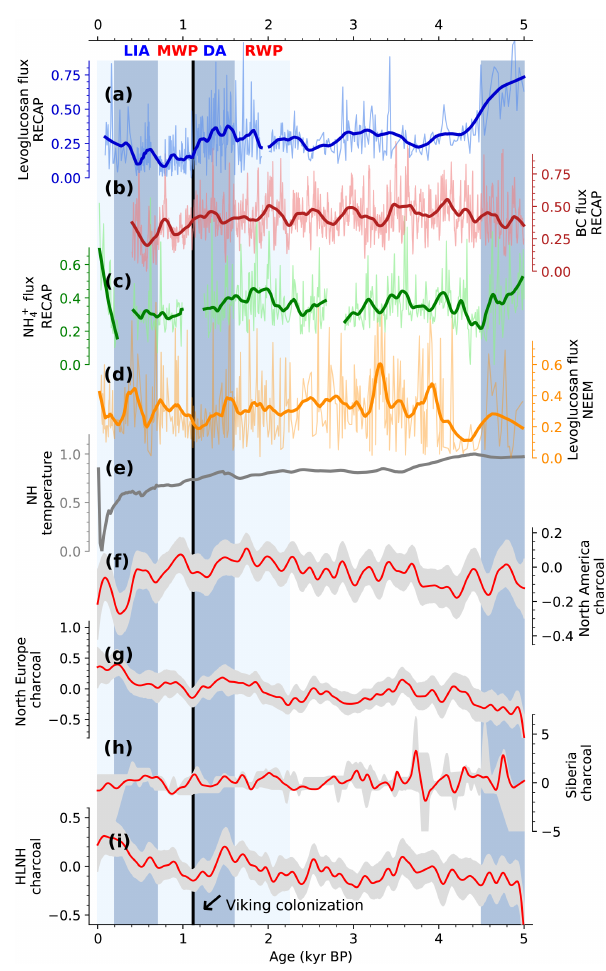
Figure 3. Normalized 5kyr time series of (a) RECAP levoglu- flux; (d) NEEM cosan flux; (b) RECAP BC flux; (c) RECAP NH + 4 levoglucosan flux (Zennaro et al., 2015); (e) NH temperature re- construction (90–30 ◦ latitude) (Marcott et al., 2013); and (f, g, h, i) charcoal composite record of North America, northern Europe, Siberia, and the Northern Hemisphere (lat > 55 ◦ ), respectively (red lines), with 0.05 and 0.95 confidence levels (grey areas). The black line indicates the time of the Viking colonization of Iceland. Age scale is indicated as 1000 years before